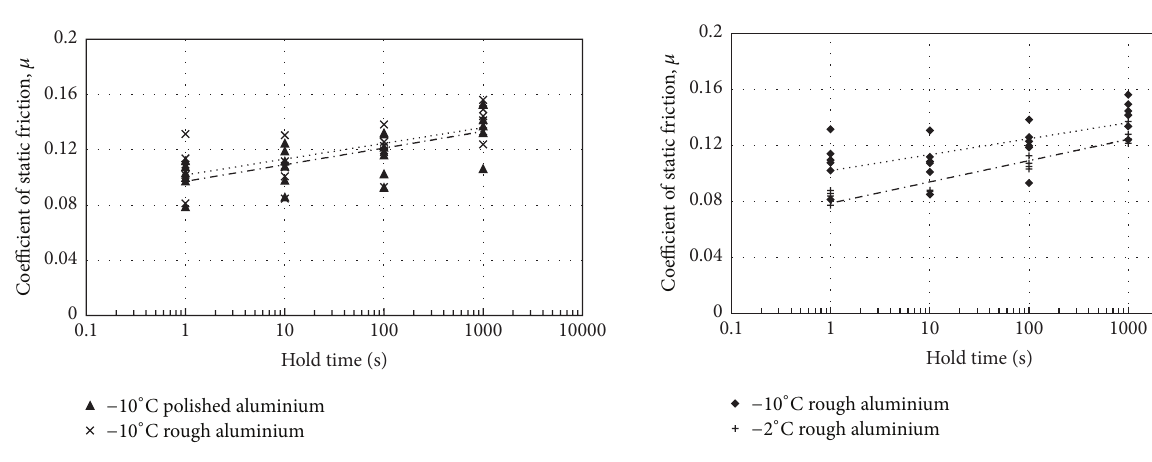
Figure 5: Friction as a function of hold time for experiments involving rough and polished aluminium at − 10 ∘ C. Individual data points represent separate experiments, and the lines represent logarithmic best fits.